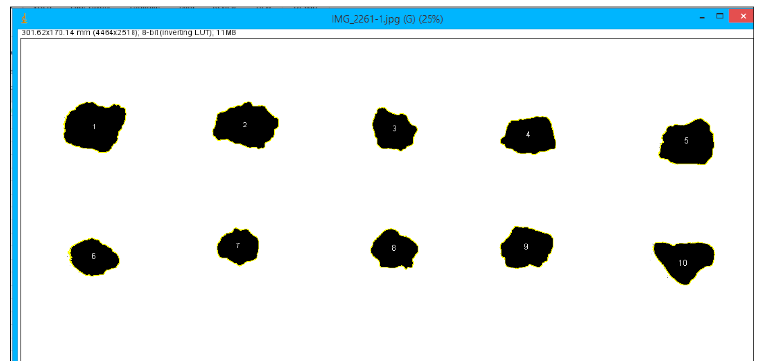
Figure 15. Binary image of aggregate with numbering.